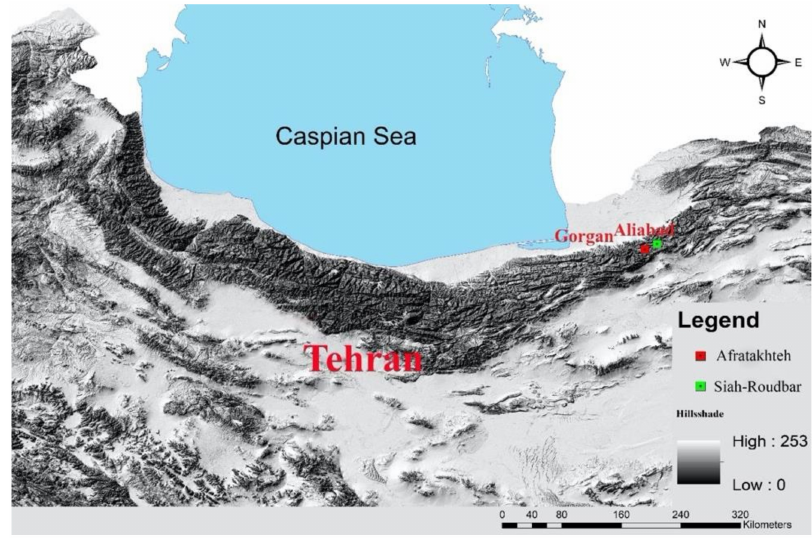
Figure 2. Location of the study areas in the eastern part of the Alborz mountains.